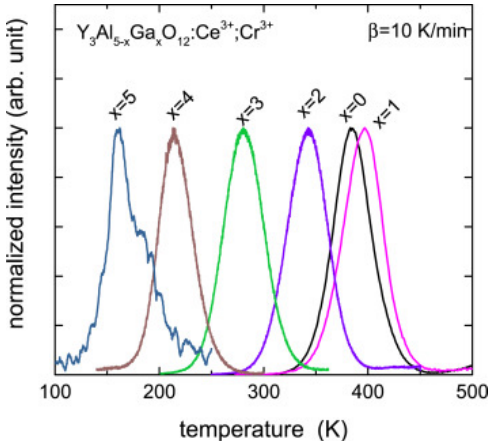
Figure 12. TL glow curves recorded at a heating rate of β = 10 K/min for Y 3 Al 5 − x Ga x O 12 :Ce 3+ ; Cr 3+ with x = 0, 1, 2, 3, 4, and 5, where Ce 3+ emission is monitored and electrons are released from Cr 2+ . Reproduced from Reference [99] with permission from The Royal Society of